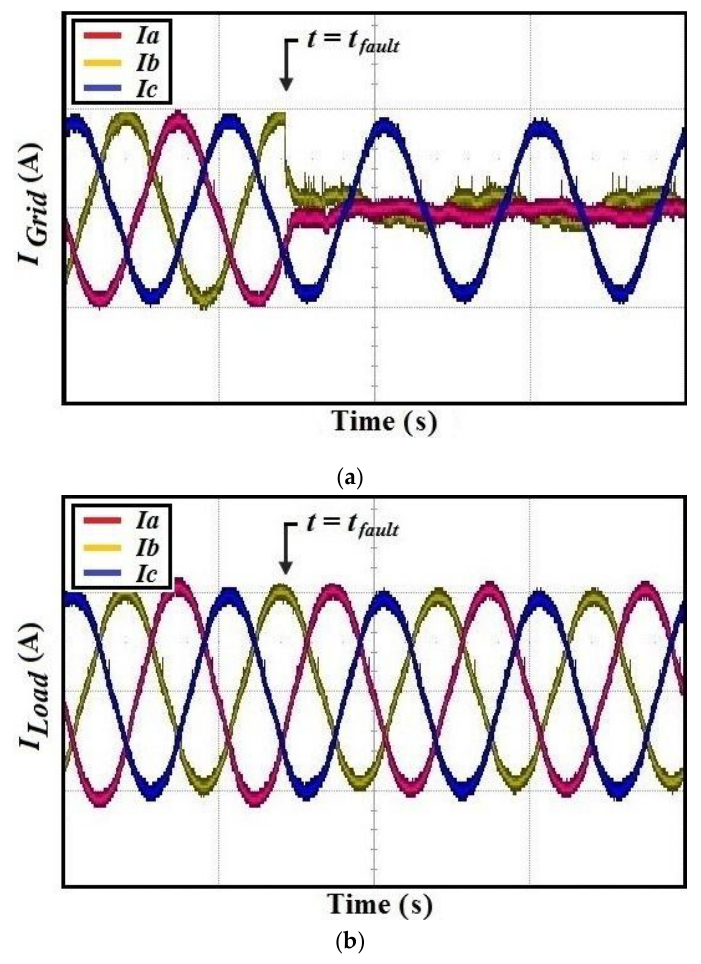
Figure 7. Experimental waveforms of the: ( a ) grid currents ( I Grid ); and ( b ) load currents ( I Load ) with the proposed asymmetrical fault correction technique during S-L-L and D-L-G faults (X-axis: 20 ms/div; Y-axis: 1 A/div).